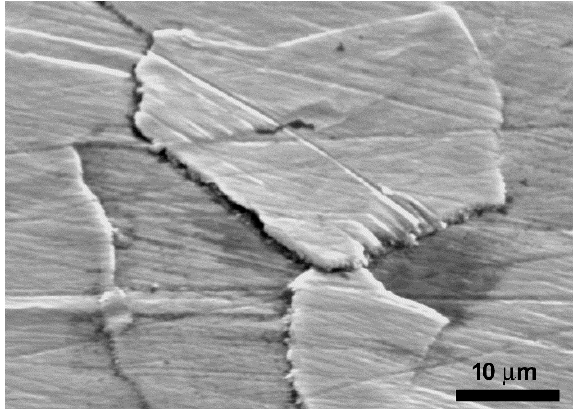
Figure 3. Detail of the surface morphology of an AISI 316L sample plasma nitrided at 430 °C, 10 3 Pa, 5 h. For further experimental details, see [116].